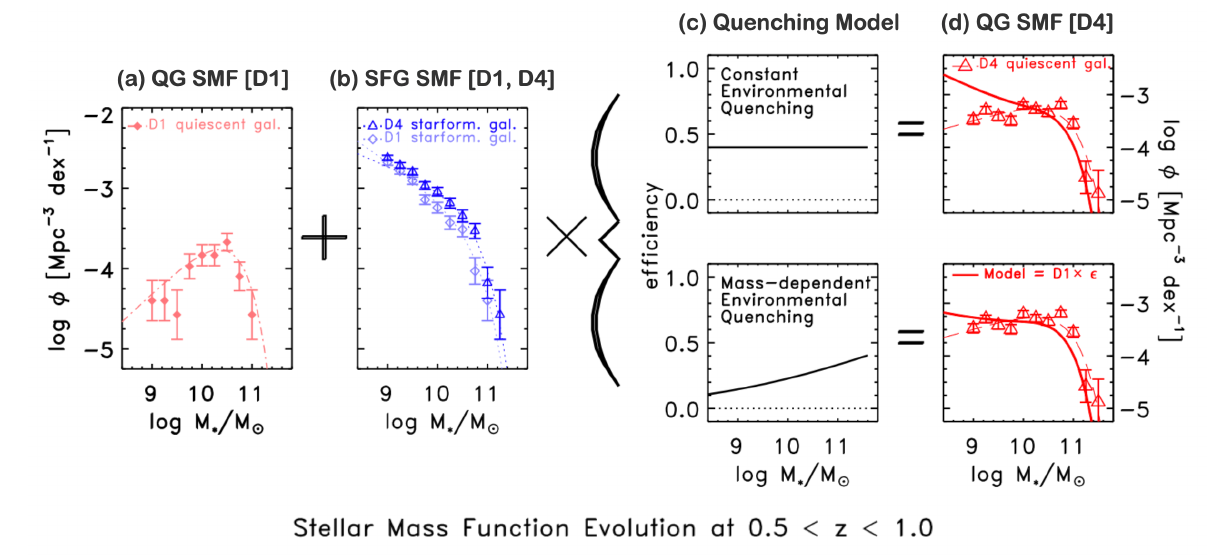
Figure 5. A toy model showing that combining the observed QG SMF in the lowest density quartile (D1, panel a ) with the steep low-mass end of the SFG SMF (panel b ) observed in both the highest (D4) and lowest (D1) density quartiles requires a mass-dependent environmental quenching model (panel c , bottom) to avoid a strong excess in the low-mass quenched galaxies in overdense environ- ments (panel d ). Both quenching models are able to reproduce the high-mass end. Figure reproduced by permission of the ©AAS from Figure 5 in Papovich et al.